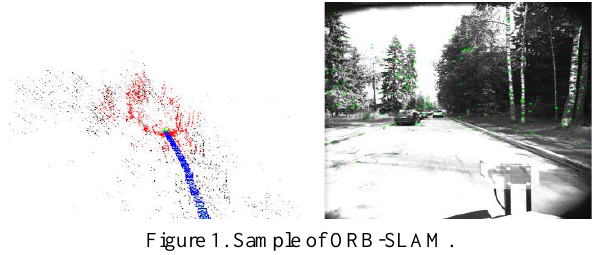
Figure 1. Sample of ORB-SLAM.